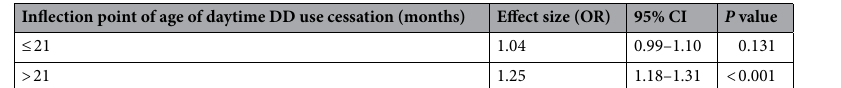
Table 5. Threshold effect analysis of duration of DD use on PNE using piece-wise regression. Effect: Primary enuresis; Cause: Age of DD use cessation. Adjusted: age(years); mother’s education(years); residence; UTI; constipation; anaphylactic disease; family history. DD disposable diaper, UTI urinary tract infection.